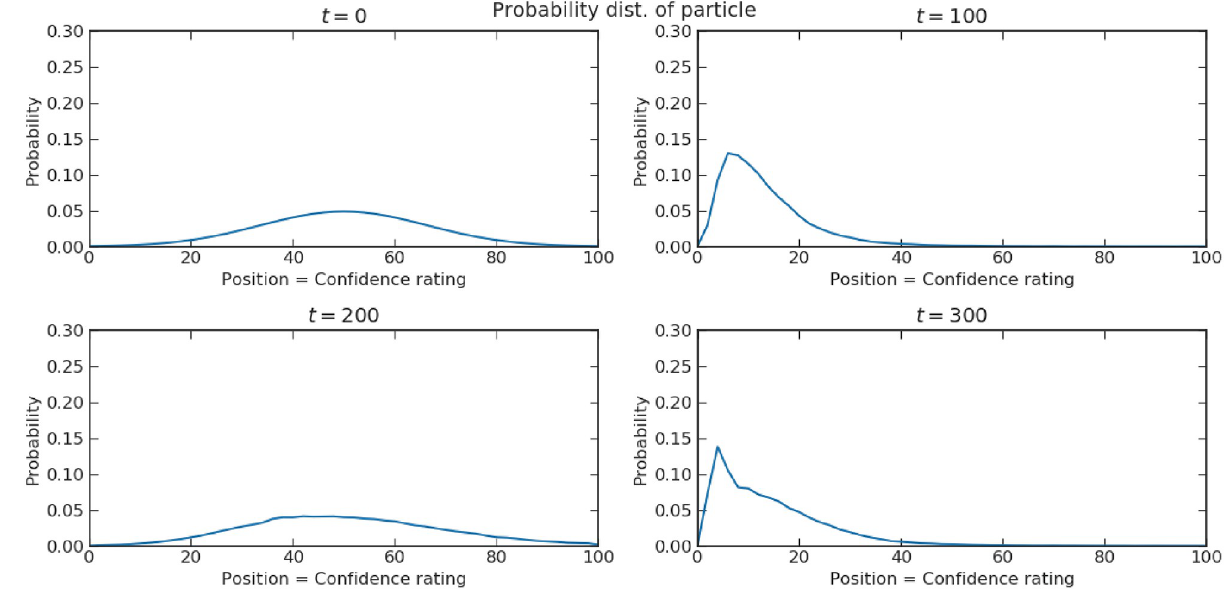
Fig 9. Probability distribution of the discrete-time quantum walk (DTQW) described in the text in the position space at different times.